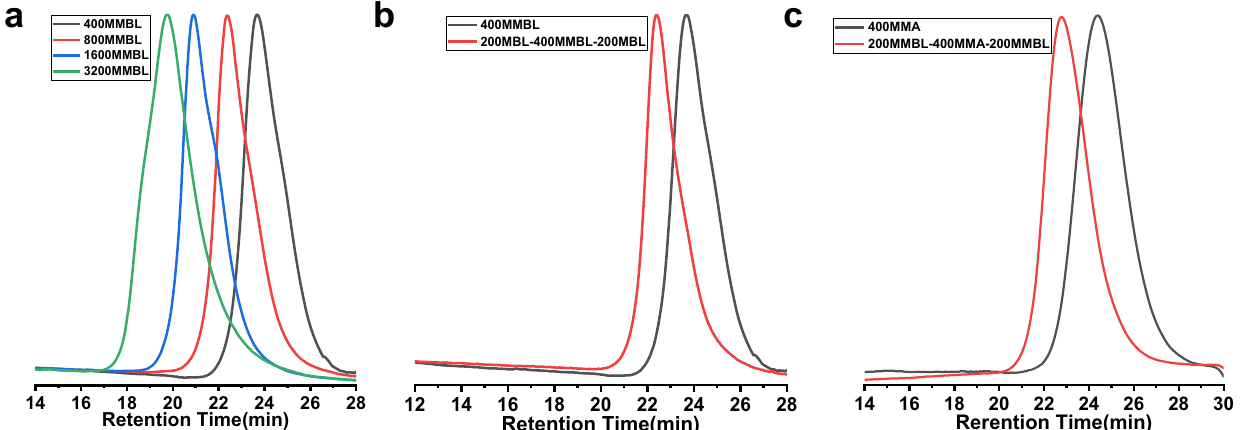
Fig. 3 GPC analysis. a GPC traces of PMMBL produced by μ Hex [P(NI i Pr)Ph] 2 /(BHT) 2 AlMe LP at various [MMBL] 0 /[ μ Hex [P(NI i Pr)Ph] 2 ] 0 /[(BHT) 2 AlMe] 0 ratio at RT. Conditions: [MMBL] 0 /[ μ Hex [P(NI i Pr)Ph] 2 ] 0 /[(BHT) 2 AlMe] 0 = 400:1:4, 800:1:4, 1600:1:4, 3200:1:4, [MMBL] 0 = 0.936 M. b GPC traces of homopolymer and tri-BCP produced from the sequential block copolymerization of MMBL and MBL by μ Hex [P(NI i Pr)Ph] 2 /(BHT) 2 AlMe in dichloromethane at RT, [MMBL] 0 = 0.936 M. c GPC traces of homopolymer and tri-BCP produced from the sequential block copolymerization of MMA and MMBL by μ Hex